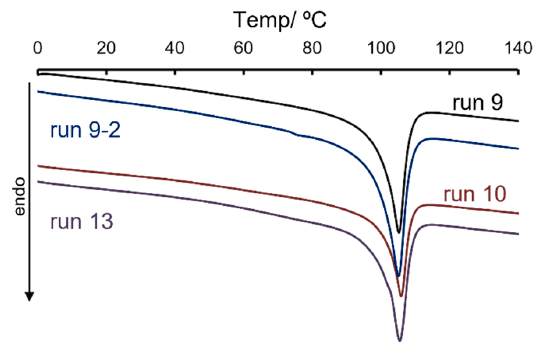
Figure 3. DSC thermograms of hydrogenated poly(M1 ‐ co ‐ DCD)s (M1:DCD = 1:10, molar ratio) pre ‐ pared under various hydrogenation conditions [H 2 1.0 MPa, 3 h (run 9), 6 h (run 10), and 24 h (run 13); H 2 2.0 MPa, 3 h (run 9 ‐ 2)]. Detailed data are shown in Table 1.